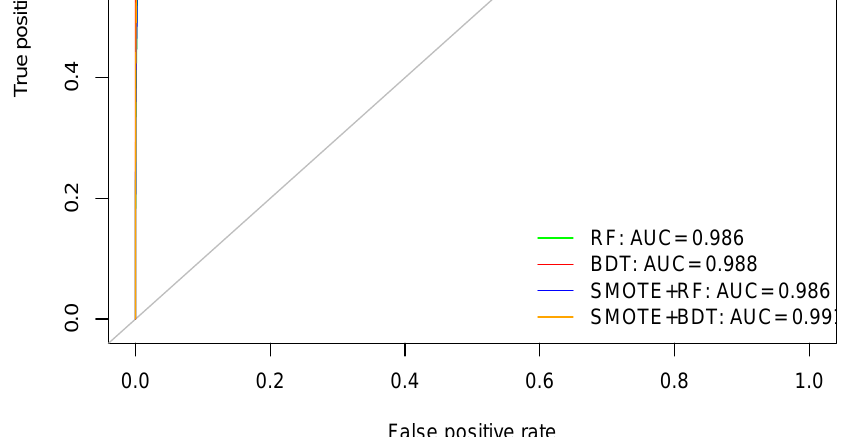
Figure 2. The ROC curves.